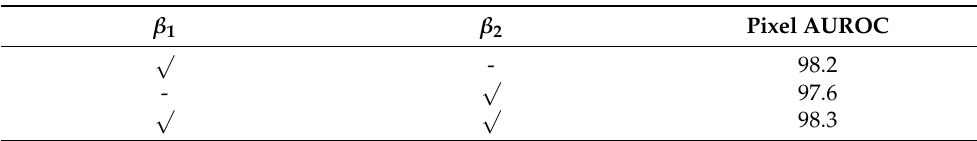
Table 5. Results of various β i combinations in the carpet dataset. “ otherwise it was set to